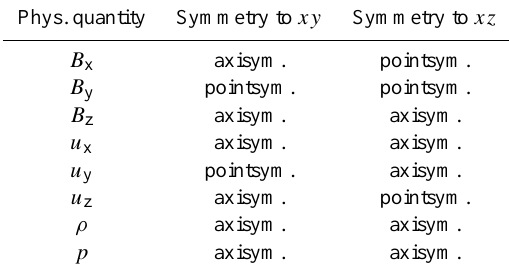
Table A1. Symmetries of the situation considered. Axisymme- try of a quantity f (x,y,z) to the xy-plane means f (x,y, − z) = f (x,y,z) , point symmetry means f (x,y, − z) = − f (x,y,z) , anal- ogous with respect to the xz-plane. Phys. quantity Symmetry to xy Symmetry to